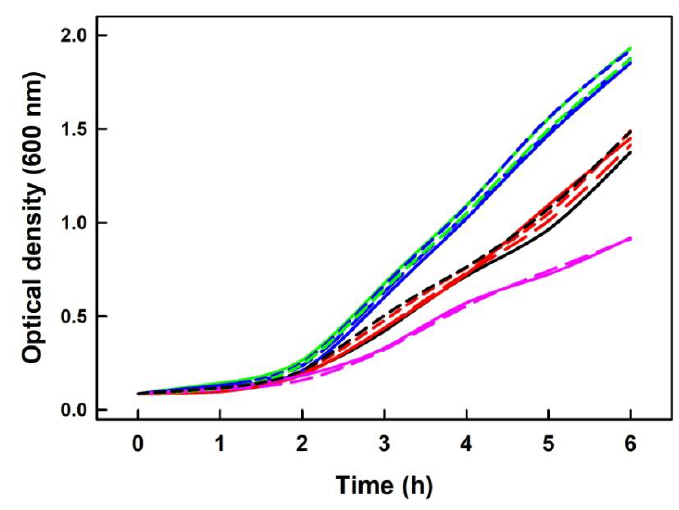
Figure 13. The effects of Na 2 S on bacterial growth in the presence of DOXY. Representative growth curves of parallel samples derived from three independent experiments show no significant effects of Na 2 S on E. coli cells undergoing DOXY treatment. Control (n = 2; dash green, green), 50 nM DOXY (n = 2; dash black and black), 10 µ M Na 2 S (short dash blue), 25 µ M Na 2 S (long dash blue), 50 µ M Na 2 S (blue), 50/10 nM/ µ M DOXY/Na 2 S (short dash red), 50/25 nM/ µ M DOXY/Na 2 S (long dash red), 50/50 nM/ µ M DOXY/Na 2 S (red), 100/50 nM/ µ M DOXY/Na 2 S (dash pink) and 100 nM DOXY (pink). Growth of bacterial culture was measured as change in optical density at 600 nm (OD 600 ) within six